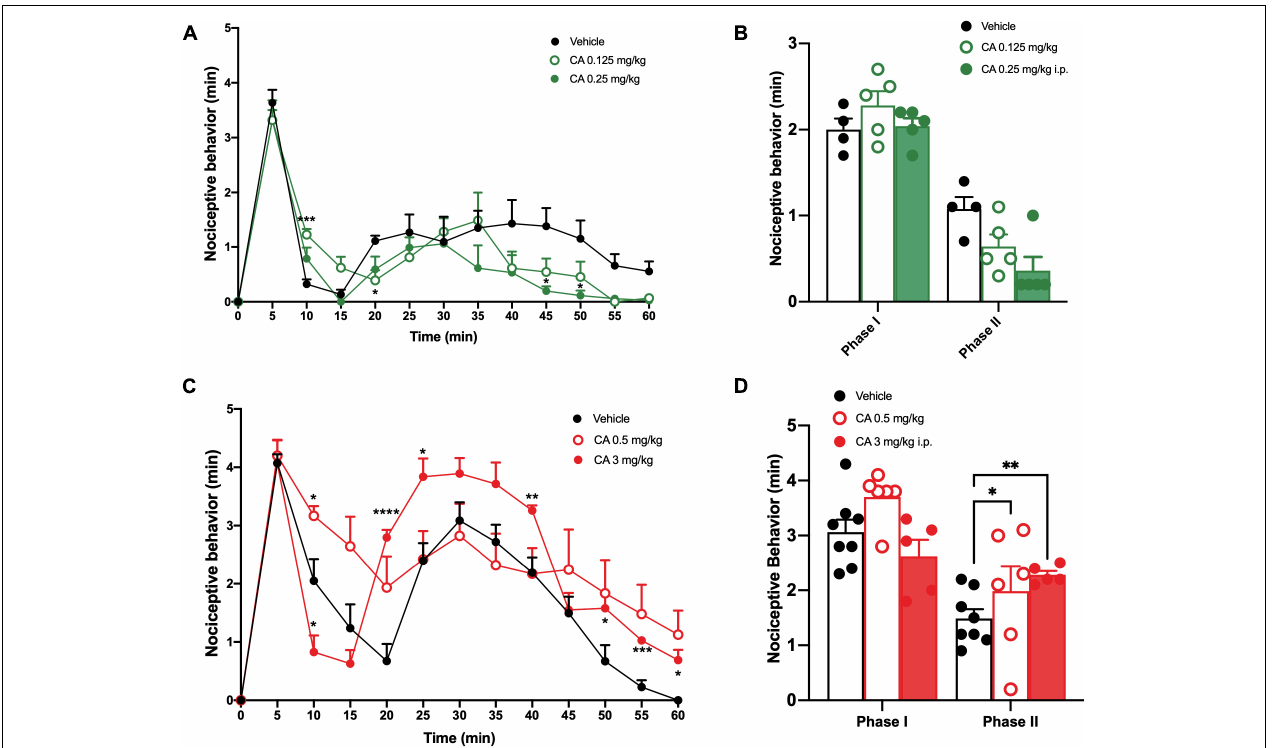
FIGURE 1 | Low doses of cinnabarinic acid significantly reduced formalin-induced nocifensive response in wild-type (WT) mice. (A) Effect of lowest doses of cinnabarinic acid (0.125 and 0.25 mg/Kg) on formalin-induced pain behaviours, including lifting, flinching, and licking, observed for 60 min at 5 min intervals. (B) Total pain scores were classified as phase I (0–10 min) and phase II (30–60 min) in formalin-injected mice treated with vehicle or with cinnabarinic acid (0.125 and 0.25 mg/Kg). (C) Effect of highest doses of cinnabarinic acid (0.5 and 3 mg/Kg) on formalin-induced pain behaviours, including lifting, flinching, and licking, observed for 60 min at 5 min intervals. (D) Total pain scores were classified as phase I (0–10 min) and phase II (30–60 min) in formalin-injected mice treated with vehicle or with cinnabarinic acid (0.5 and 3 mg/Kg). Data are expressed as the means ± SEMs (two-way ANOVA for repeated measures with Tukey’s post-hoc test, * p < 0.05, ** p < 0.01, and **** p < 0.0001 vs. vehicle, n =